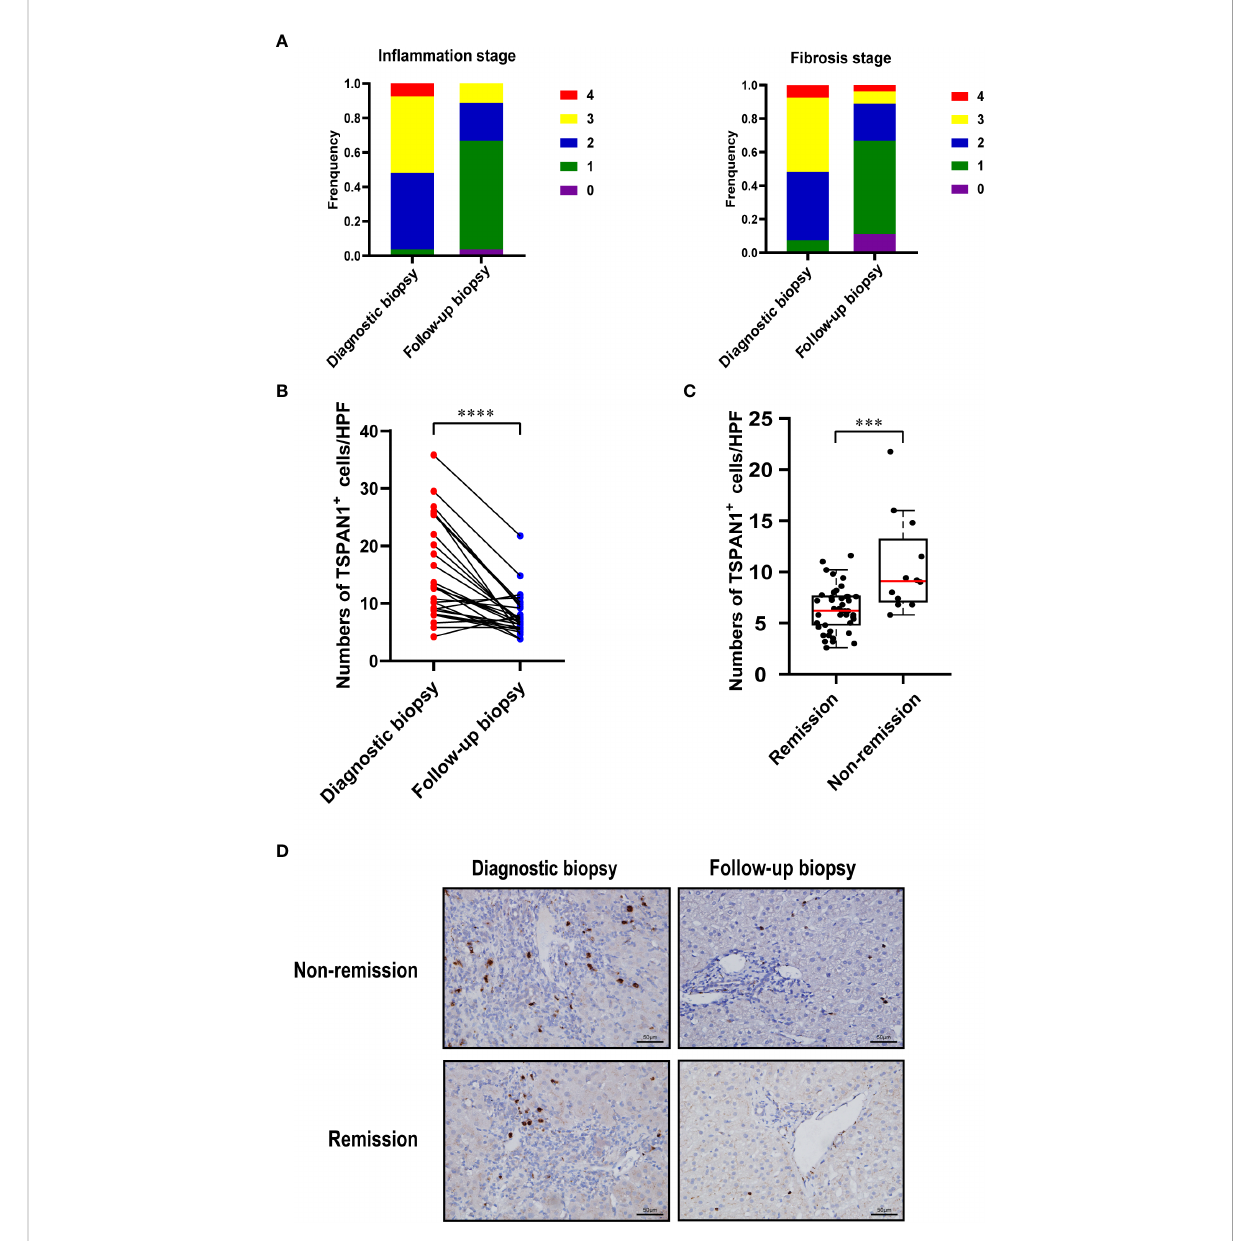
FIGURE 7 TSPAN1 expression was decreased after immunosuppressive treatment. (A) Hepatic in fl ammation and fi brosis stages were evaluated in diagnostic biopsies and follow-up biopsies in AIH patients. (B) Expression of TSPAN1 in paired diagnostic biopsies versus follow-up biopsies. (C) Expression of TSPAN1 in remission versus non-remission group. (D) Representative immunohistochemical staining of TSPAN1 in a diagnostic biopsy (left) and a paired follow-up biopsy (right) from non-remission (top) and remission group (bottom) (×400). *** P < 0.001, **** P <